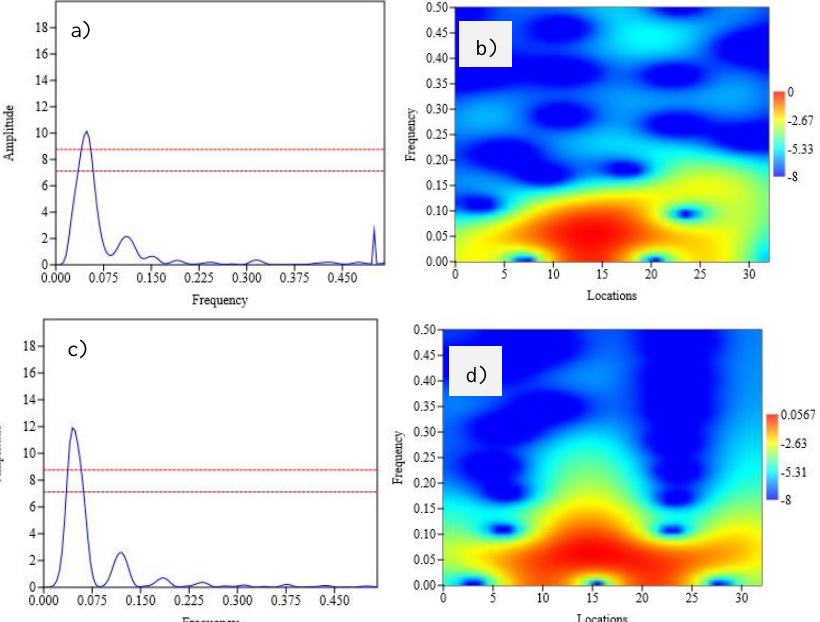
Figure 5. Periodogram for PGA and intensity (1800 events) at a radius of 1700 km where Odisha is the center. ( a ) periodogram for PGA; ( b ) periodogram for intensity.